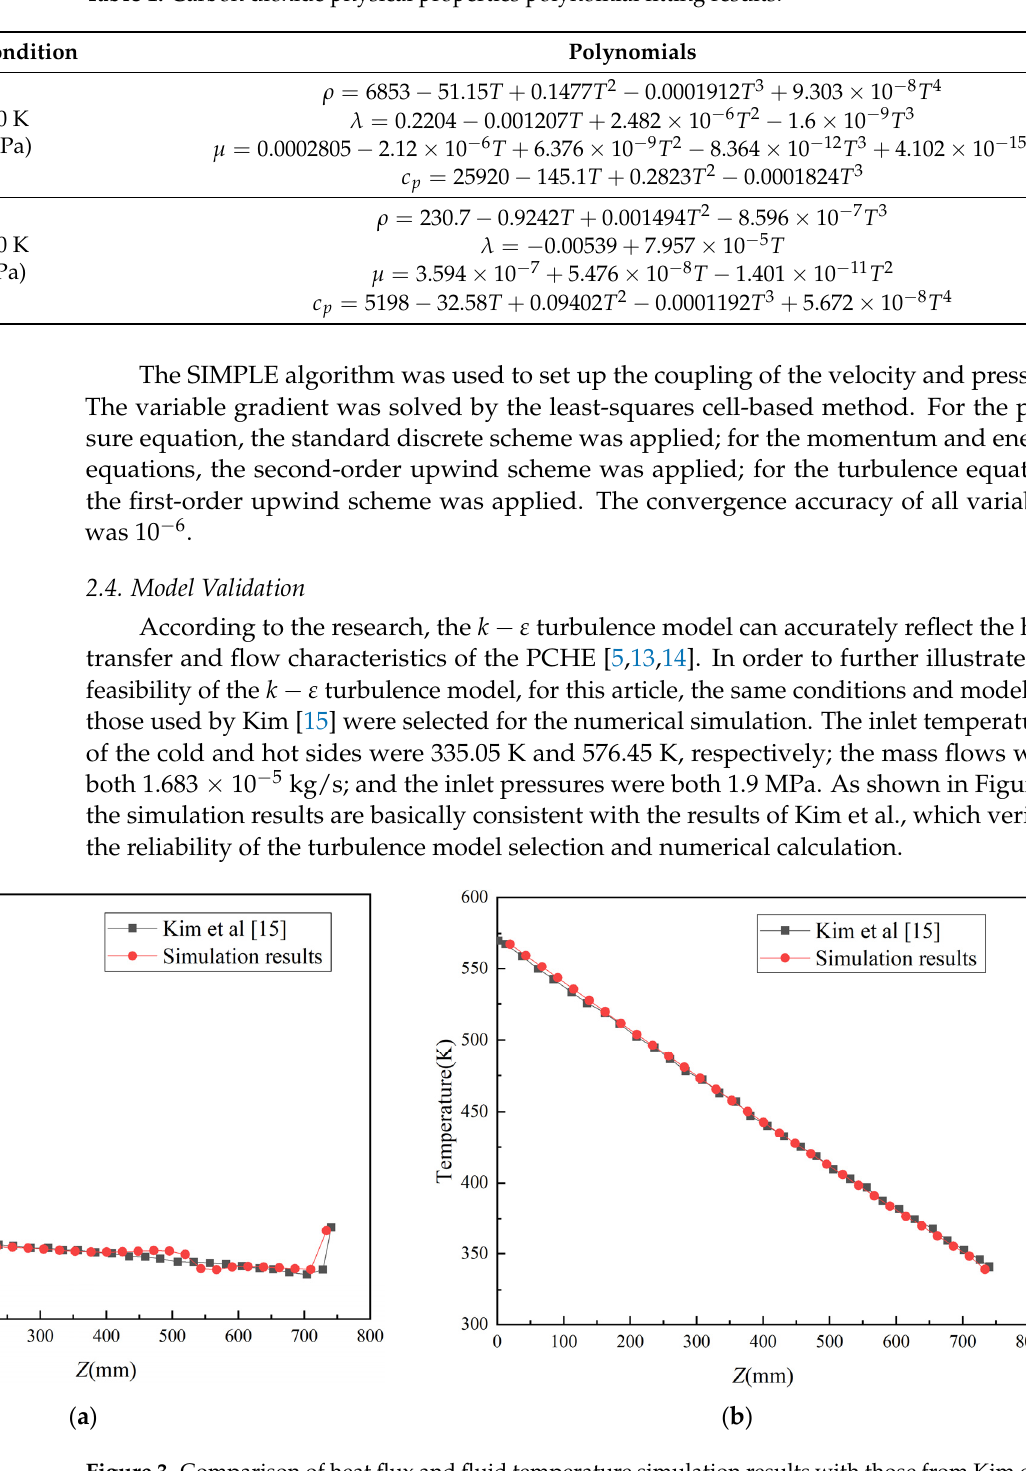
Table 1. Carbon dioxide physical properties polynomial fitting results.